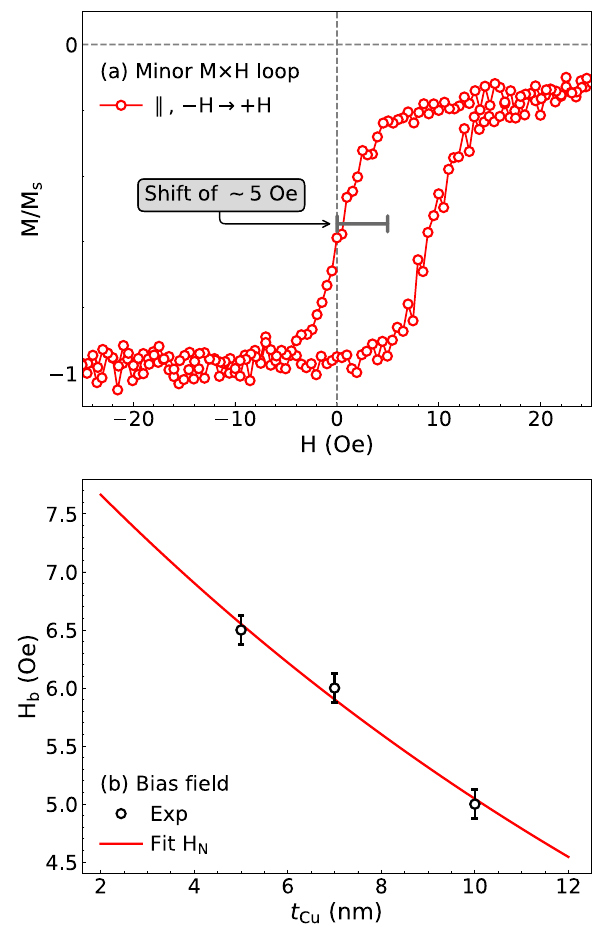
10 nm. The curve is measured = 5 Oe. ( b ) Bias ∼ t M M 780 emu/cm 3 and Cu and assuming s s, NiFe = = = 2.58 0.09 nm and (cid:31) 170 19 nm, which fall into the range = ± = ±